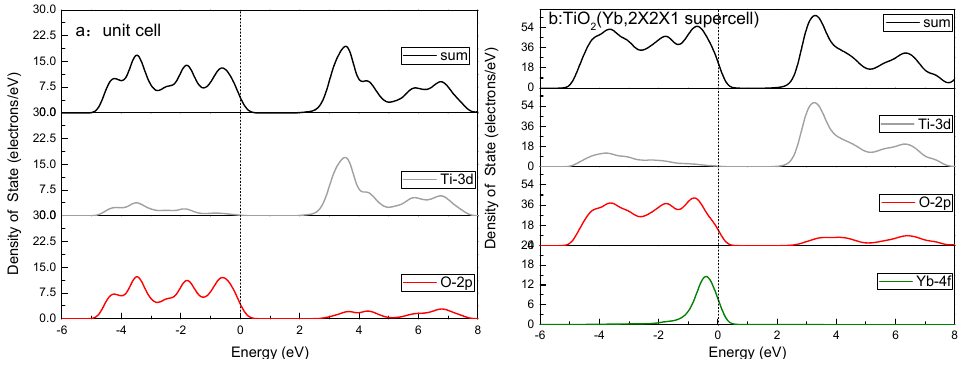
Figure 11. The calculated density of states of pure TiO 2 and Yb-doped TiO 2 (2 × 2 × 1 supercell).